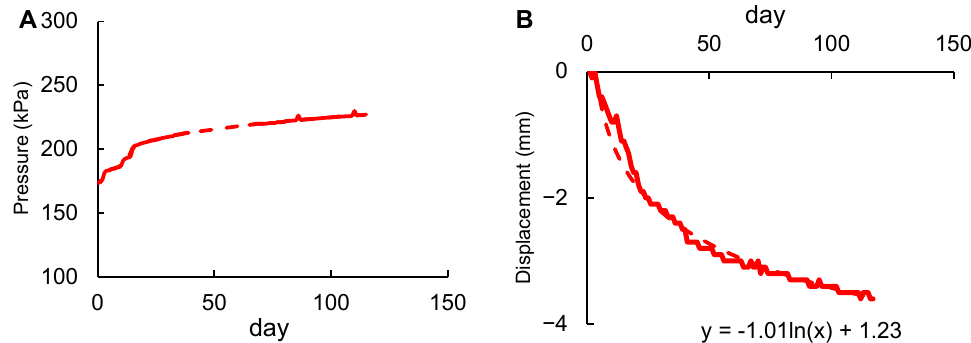
Figure 9. Vertical stress at 21 m and displacement from 16 m to 21 m in the filling areas during winter break (( A ) is the pressure over time during winter, and ( B ) is the displacement over time during winter. The solid line is the measured data, and the dashed line is the estimation of missing data due to a lack of data).